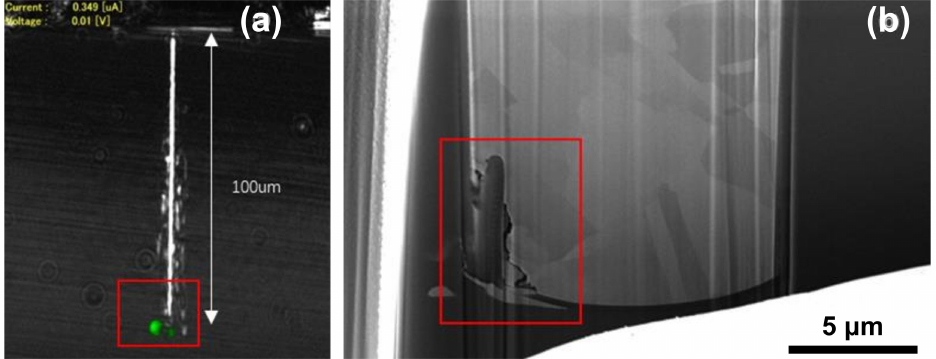
Figure 8. ( a ) Hot spot on failed TSV bottom in wafer C. ( b ) Si striation and copper diffuse in hot spot area confirmed by FIB.